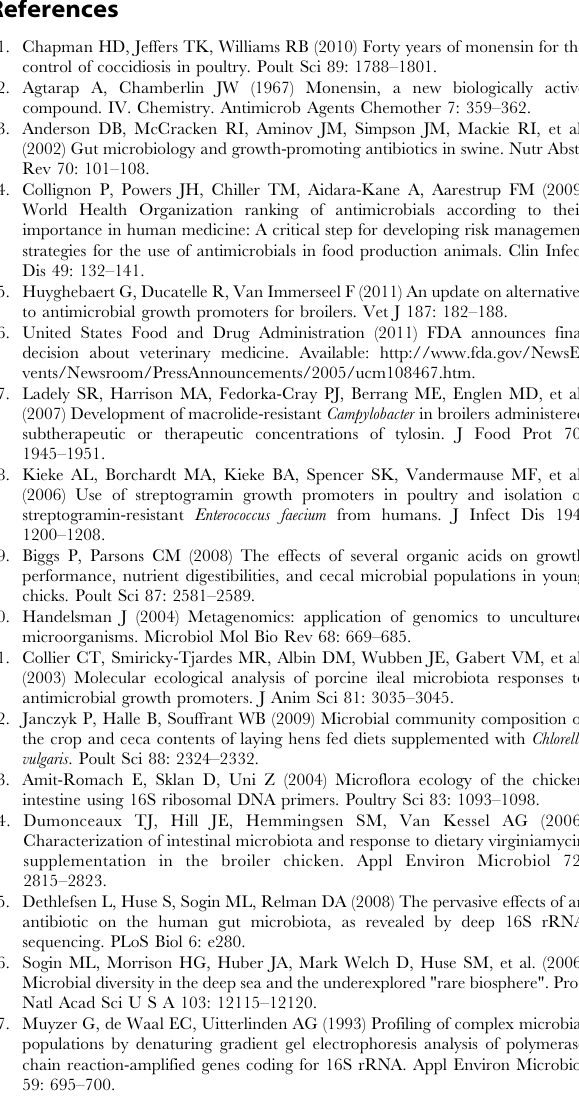
Figure S3 Distribution of functional groups from shot- gun metagenome sequencing, using the broadest func- tional subsystem classification in MG-RAST (n =29). For each timepoint, C = control diet, M = monensin treatment, V = monensin/virginiamycin treatment, and T = monensin/tylosin treatment. Figure S4 Breakdown of functional group distributions at D14C using subsystem analysis in MG-RAST. All other timepoints and treatments were similar in their distributions. Figure S5 Two-way hierarchical clustering of 773 functional group subsystems identified using MG-RAST, based upon normalized abundances. For each timepoint (Day 14 and Day 35), C = control diet, M = monensin treatment, V = monensin/virginiamycin treatment, and T = monensin/tylosin treatment. Table S1 Bacterial phyla distributions (%) at the three timepoints after the start of treatments. For each timepoint,